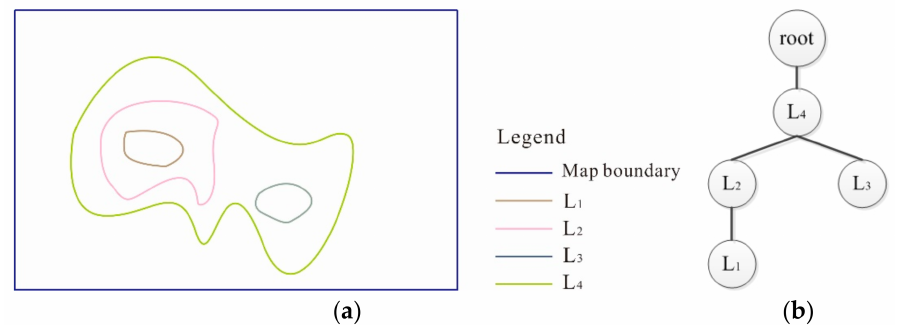
Figure 2. An adjacent relation tree for closed contours: ( a ) closed contour lines and ( b ) adjacent relation